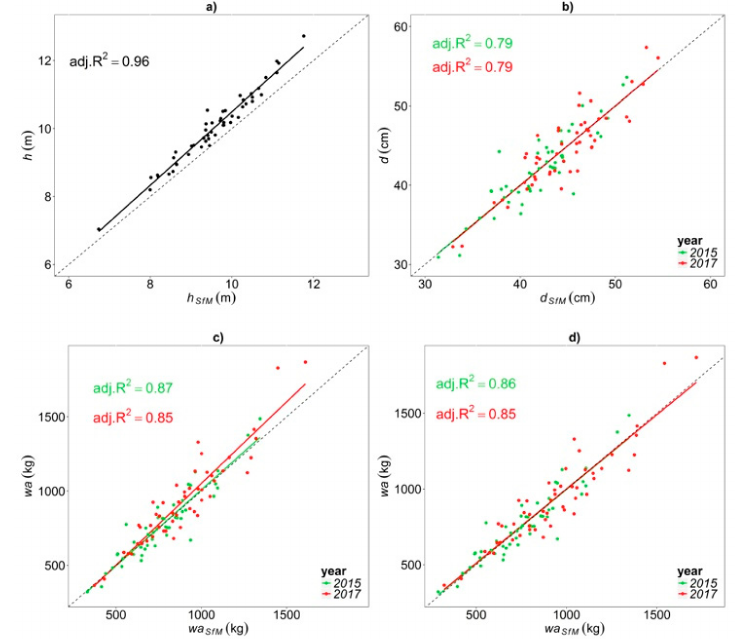
Figure 5. Scatterplots of SfM-derived variables against field-derived variables in 2017 ( a ) field-measured tree height ( h ) against SfM-measured tree height ( h SfM ) ( b ) field-measured diameter ( d ) against SfM-estimated diameter ( h SfM ); ( c ) field-estimated individual tree biomass ( w a ) against SfM-estimated individual tree biomass ( wa SfM ) following approach 1; ( d ) Field-estimated individual tree biomass ( w a ) against SfM-estimated individual tree biomass ( wa SfM ) following approach